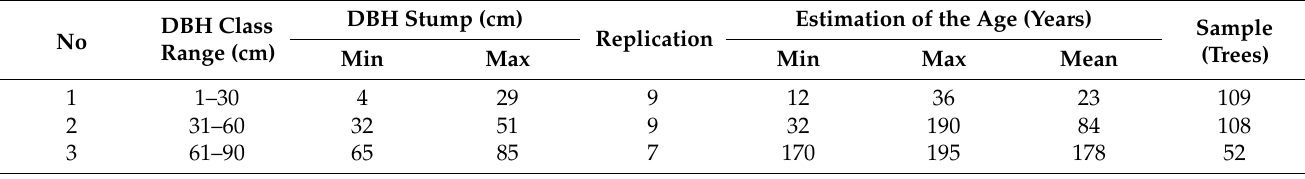
Table 1. DBH class range based on stump wood and number of samples within the Iki-no-Matsubara population. DBH No